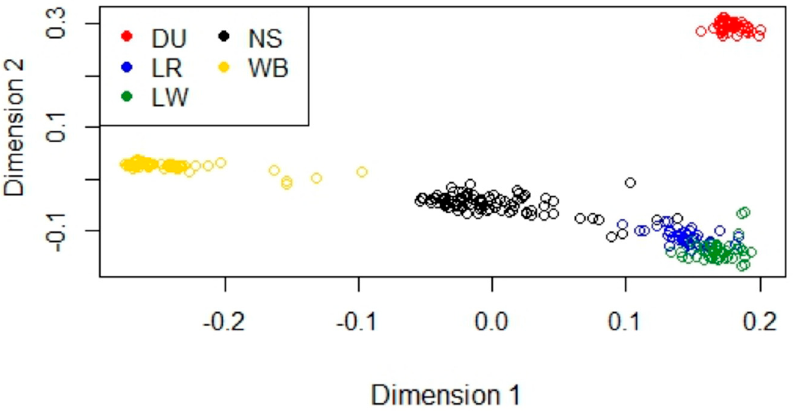
Figure 1. Multidimensional Scaling. Analysis of Nero Siciliano (NS), Landrace (LR), Large White (LW), Duroc (DU), and Wild Boar (WB).